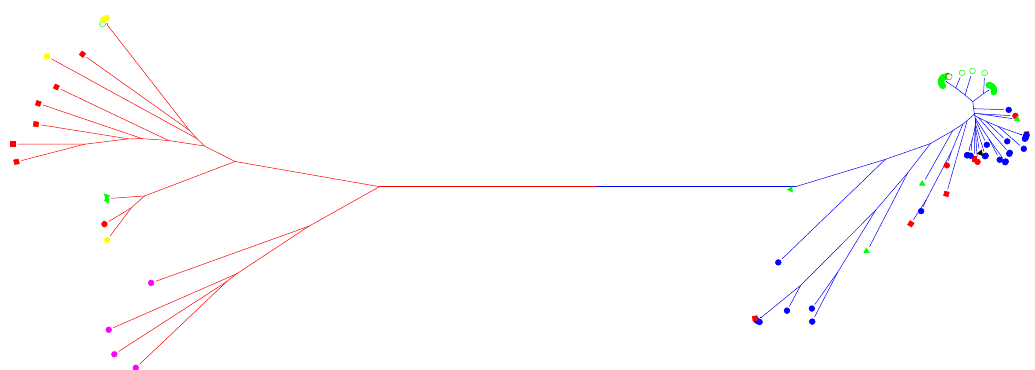
Figure 2. Radiation type of neighbor-joining tree constructed from 50K SNPs. Symbols represent the same samples as described in Figure 1. Note the sub-groups of WRN (open and closed green circles).